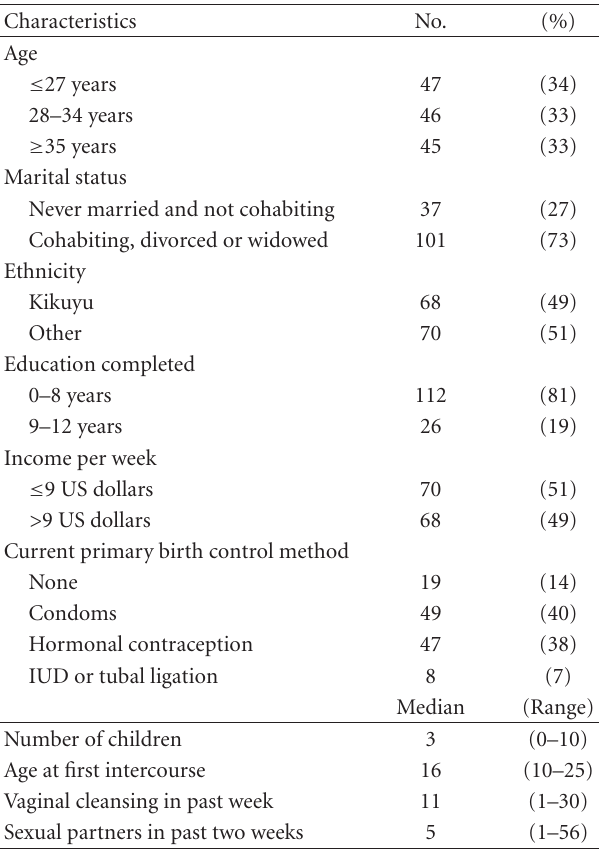
Table 1: Baseline sociodemographic and selected characteristics among study participants who completed at least one follow-up visit ( N = 138), Nairobi, Kenya,